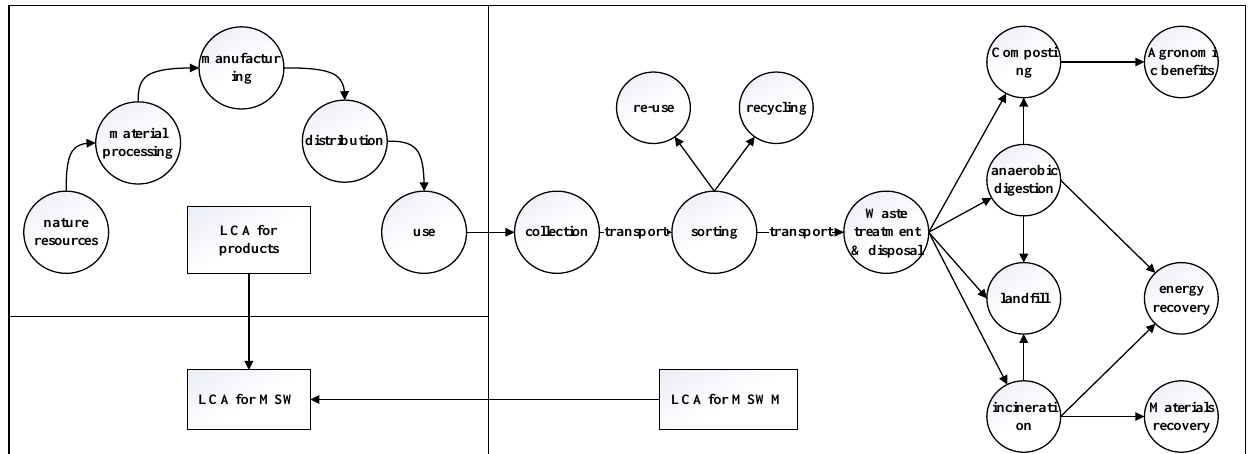
Figure 5 . Components and interrelationship of municipal solid waste LCA in Nairobi.